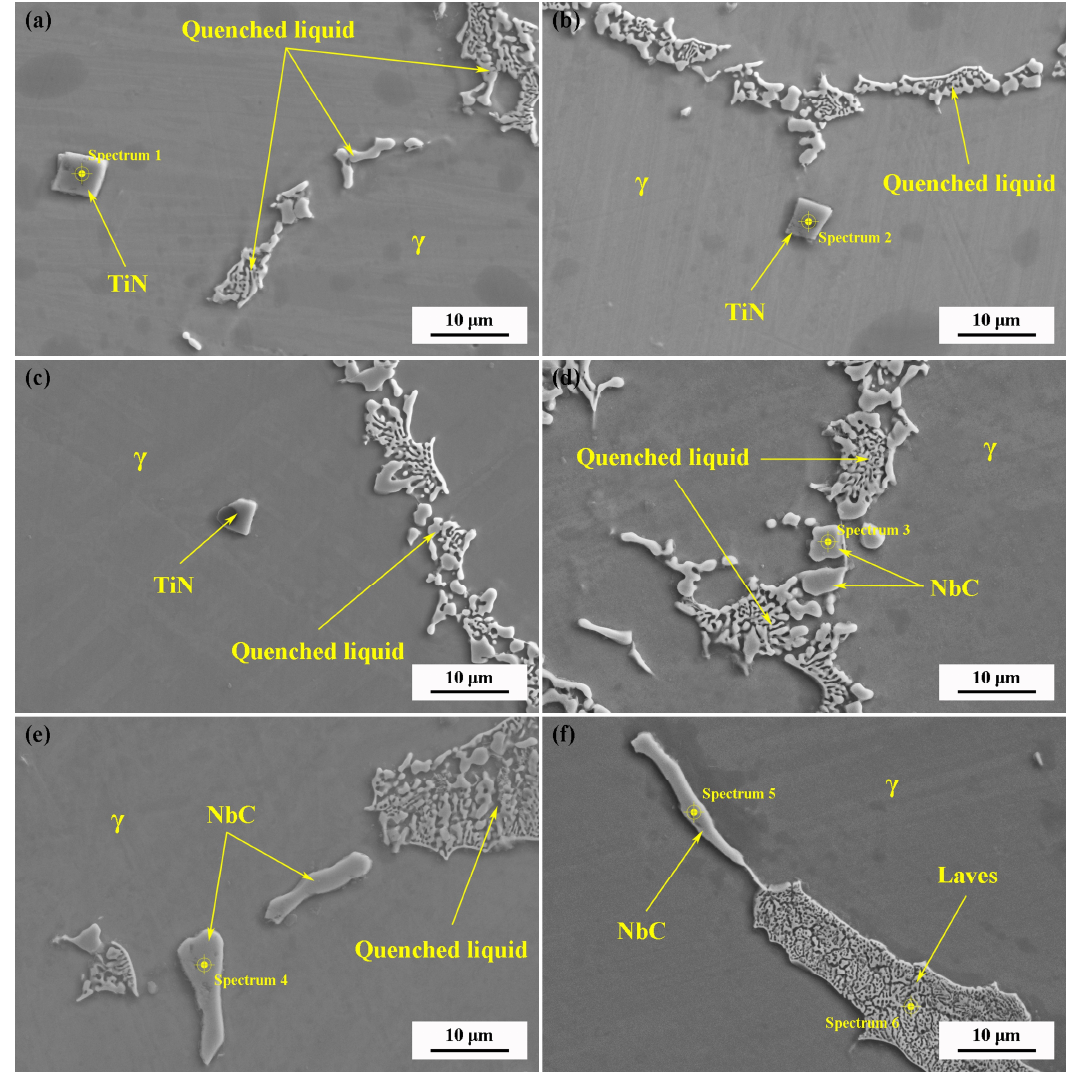
Figure 6. FESEM images of the samples at different quenching temperatures: ( a ) 1320 °C; ( b ) 1300 °C; ( c ) 1270 °C; ( d ) 1250 °C; ( e ) 1190 °C; ( f ) 1170 °C. Table 3. EDS results from spectrums marked in the FESEM images (wt %).